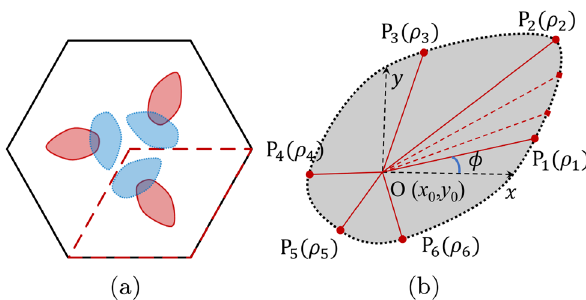
Figure 1: An illustration of a photonic or phononic lattice described -symmetric hexagonal lattice described by the MMC method. (a) A C 3 by two components (the reduced lattice is boxed in red-dashed lines), (b) geometry parameters for the adopted